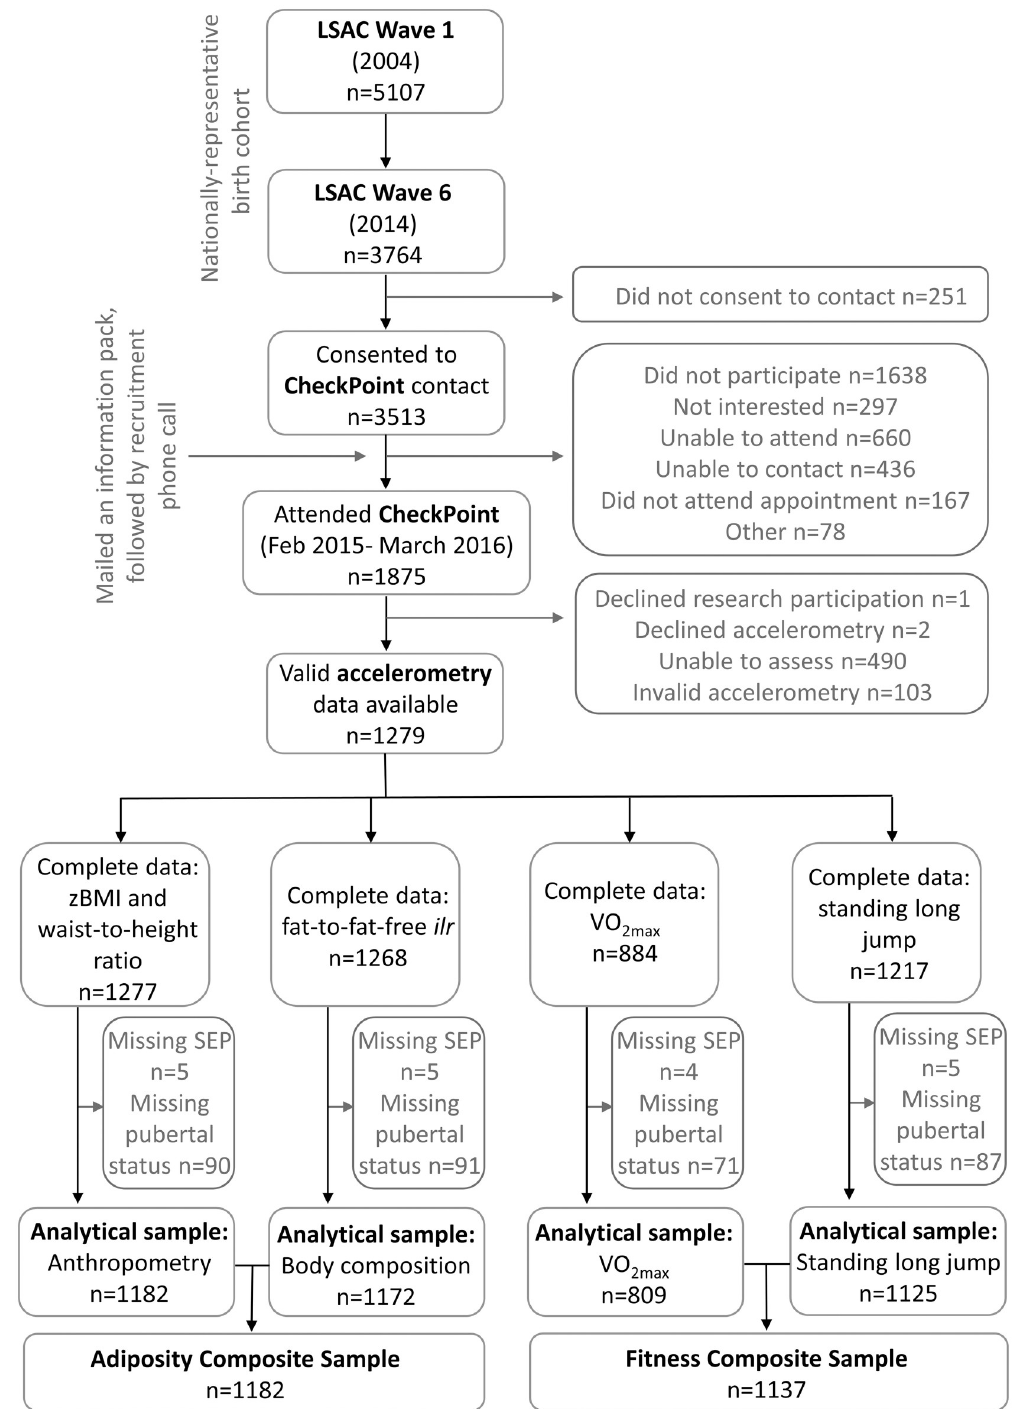
Fig 1. Participant flow. LSAC = Longitudinal Study of Australian Children; z BMI = body mass index z -score; ilr = isometric log ratio; VO 2max = predicted maximal aerobic power; SEP = socioeconomic position.